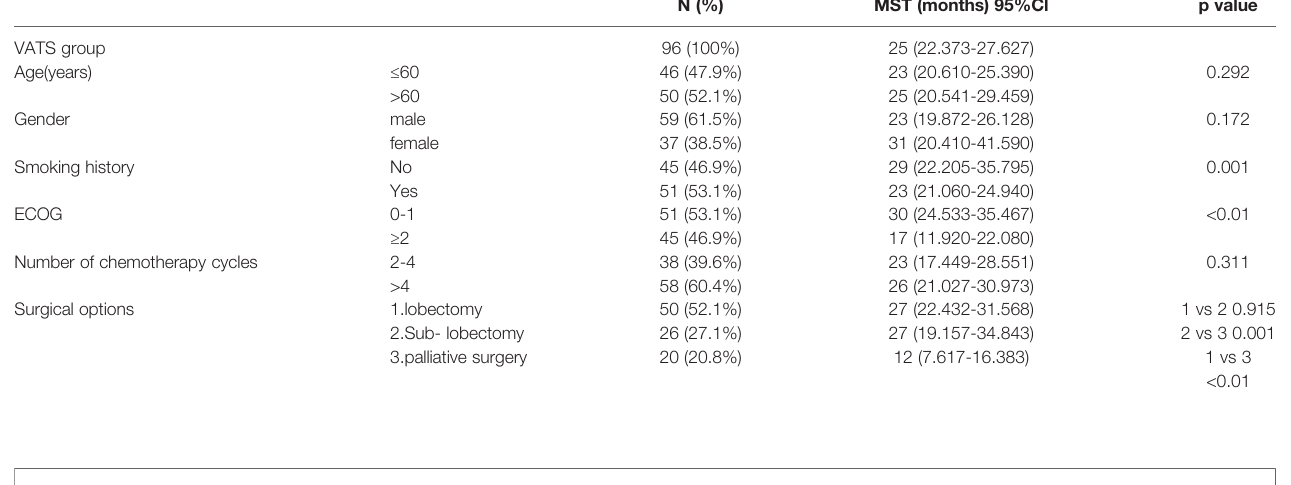
TABLE 6 | Survival analysis of VATS group.